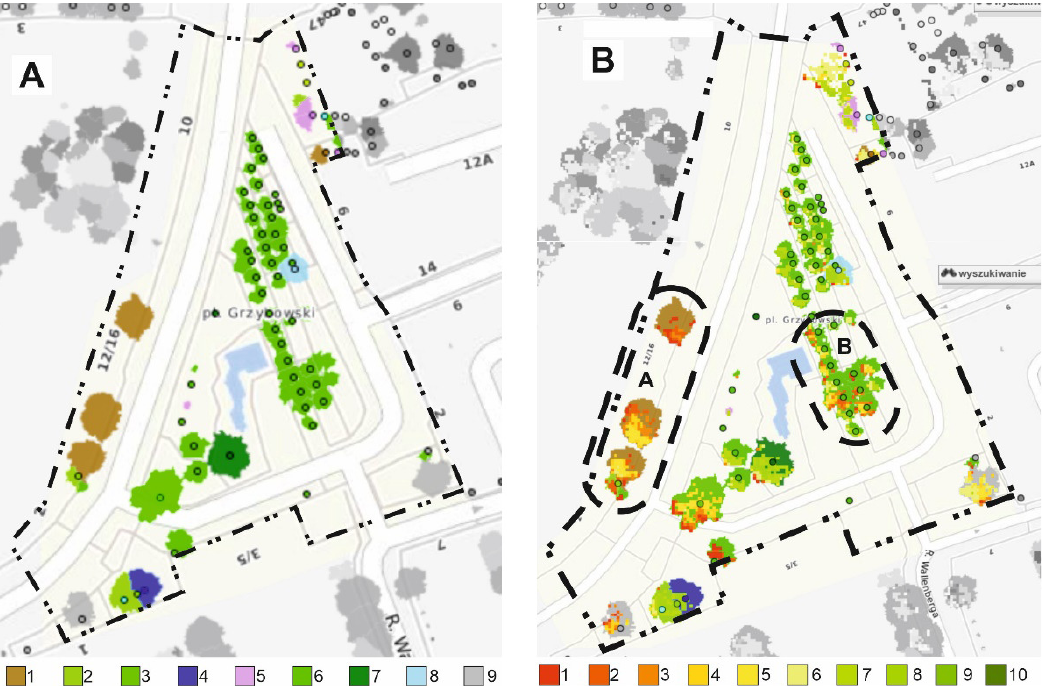
Figure 4. A) Map of tree species and crown cover. Legend: 1. Aesculus sp., 2. Acer sp., 3. Populus sp., 4. Robinia sp.,